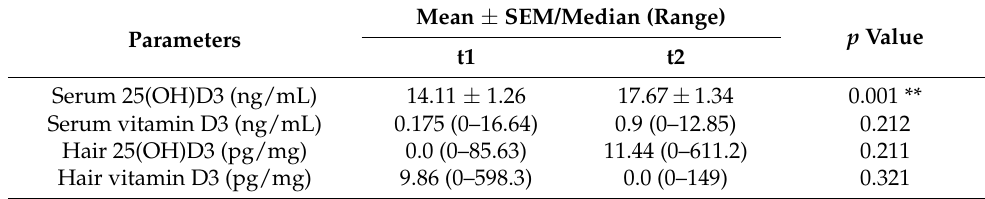
Table 2. A comparison of the parameters determined during the two sampling periods.